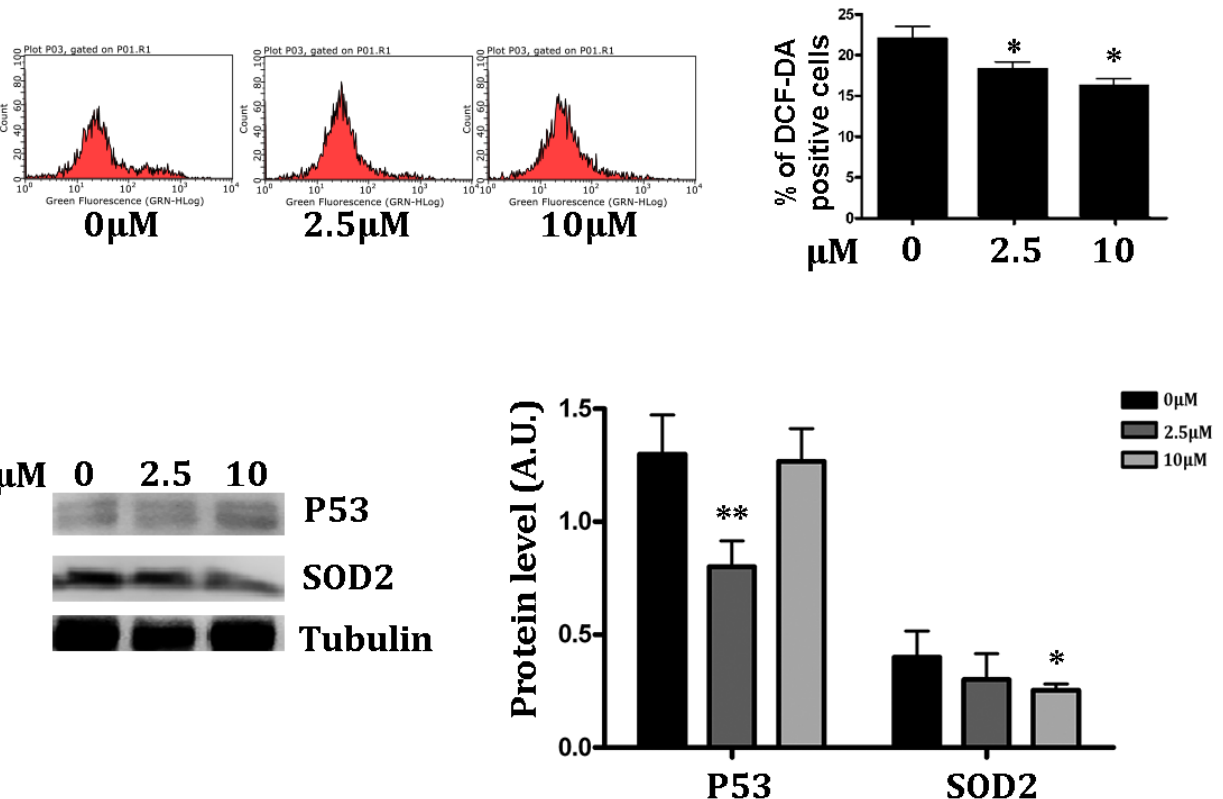
Figure 3. RSV treatment increases intracellular antioxidant potential . Upper Panel —RSV-treated and control PC12 cells were harvested after 24 h post hypoxia and then stained with DCF-DA fluorescent dye. The FACS analysis results are represented in % positive cells in the bar graph. Data were represented as means ± SD ( n = 3), (* p <0.05, ** p <0.01). Lower Panel —The antioxidant potential of the cell was assessed by a protein expression analysis of SOD2 and p53 by Western blot. The blotted protein bands were quantified and represented in the bar chart, according to RSV treatment. Data were represented as means ± SD, ( n = 3), (* p < 0.05, ** p < 0.001).